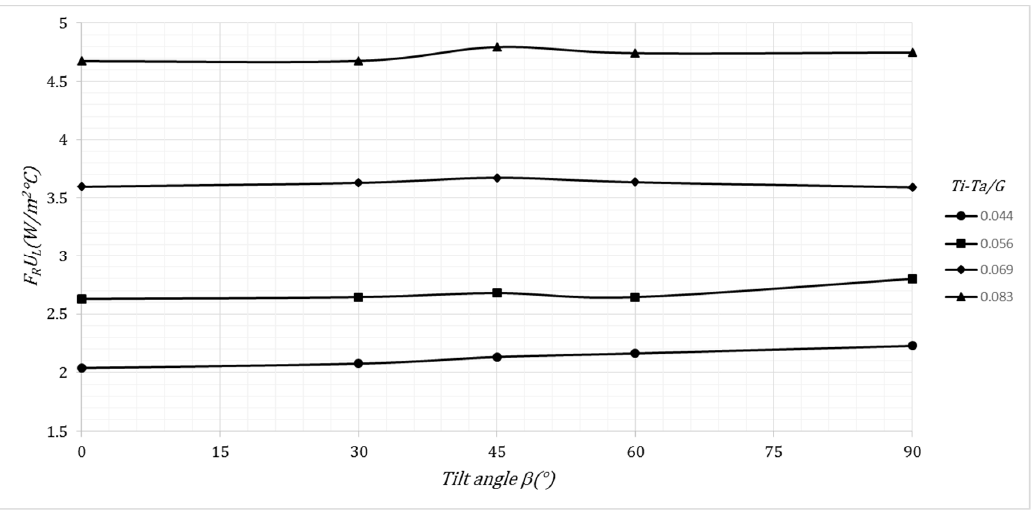
Figure 9. The a 1 : F R U Lmin as a function of β and ( Ti − Ta )/ G by Method 1 .